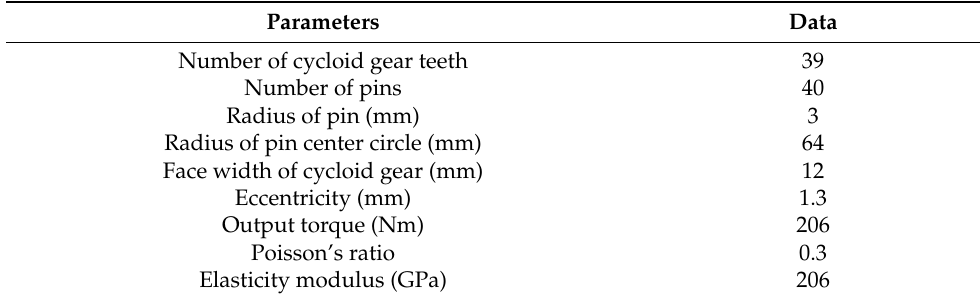
Table 1. Parameters of the cycloid-pin gear